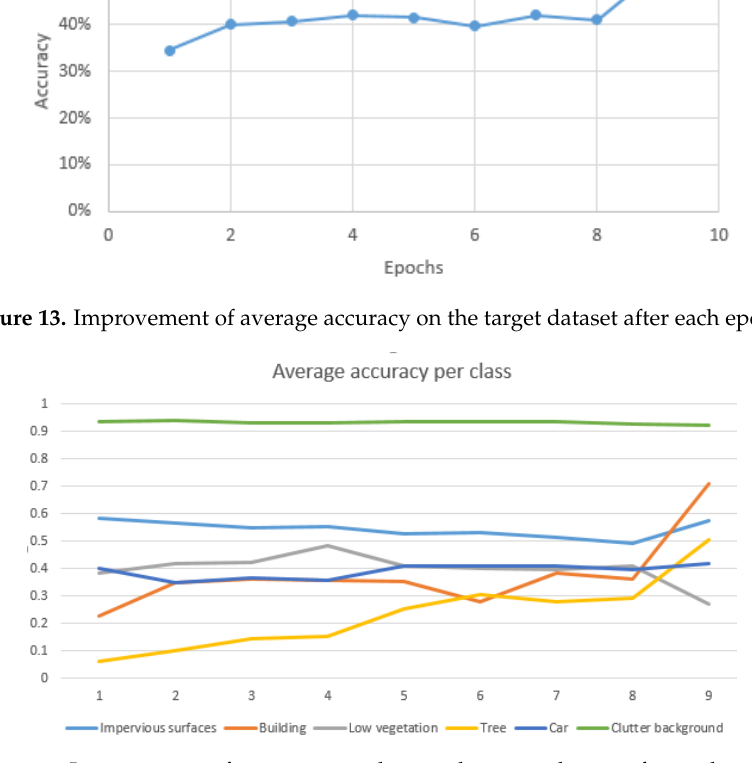
Figure 14. Improvement of accuracy per class on the target dataset after each